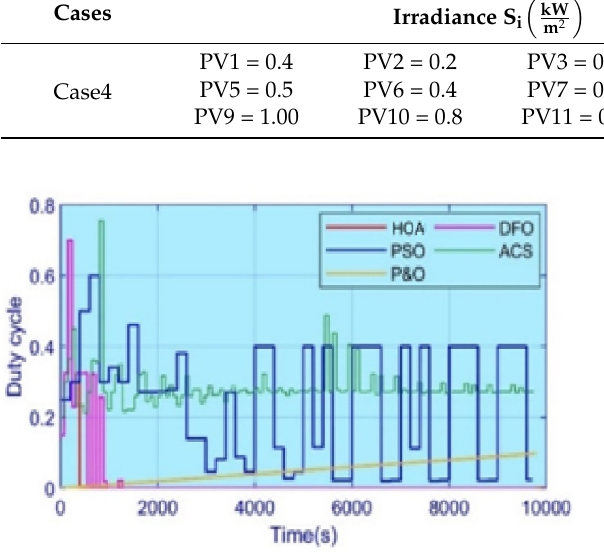
Table 3. Irradiance level of CPS Cases.